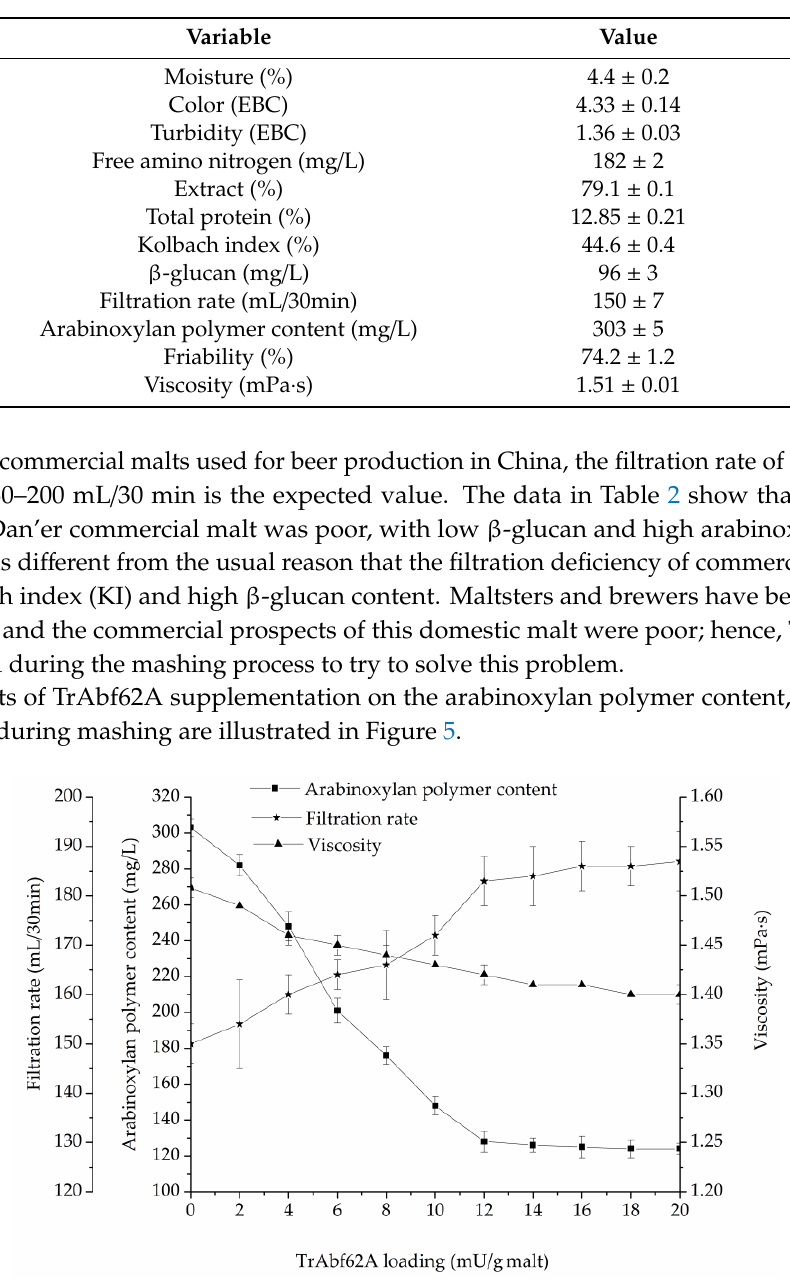
Table 2. Characteristics of the commercial malted barley used in this manuscript.